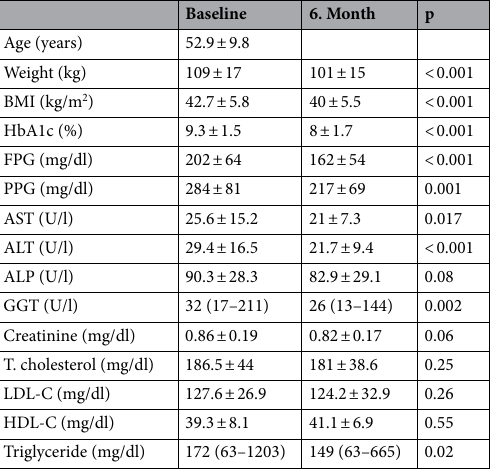
Table 1. Demographic and clinical data of the patients before and after exenatide therapy. BMI Body mass indeks, FPG Fasting plasma glucose, PPG Postprandial plasma glucose, AST Aspartate aminotransferase, ALT Alanine aminotransferase, ALP Alkaline phosphatase, GGT Gamma glutamyltransferase; T. Cholesterol Total cholesterol, HDL-C High-density lipoprotein cholesterol, LDL-C Low-density lipoprotein cholesterol.